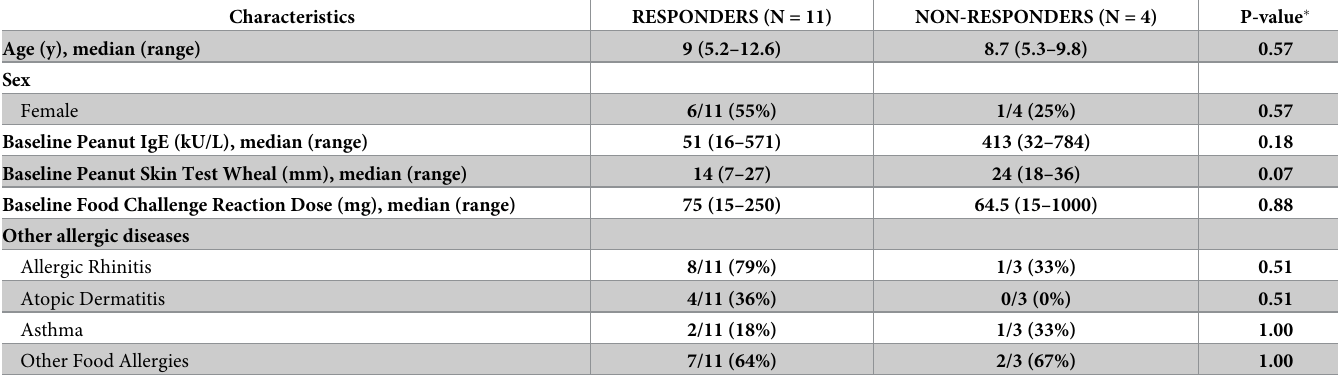
Table 1. Baseline patient demographics and clinical characteristics.